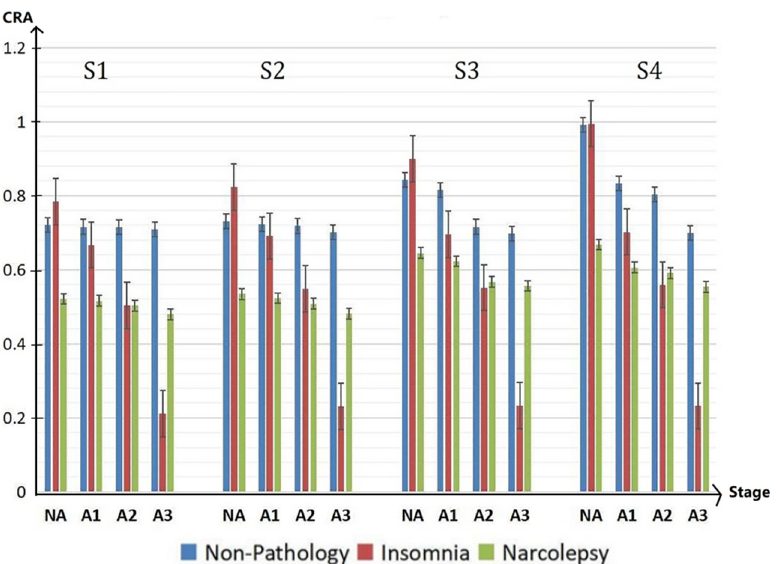
Figure 7. CRA in NA, A1, A2 and A3 period of different groups in the sleep stages S1, S2, S3, and S4 during the whole sleep.